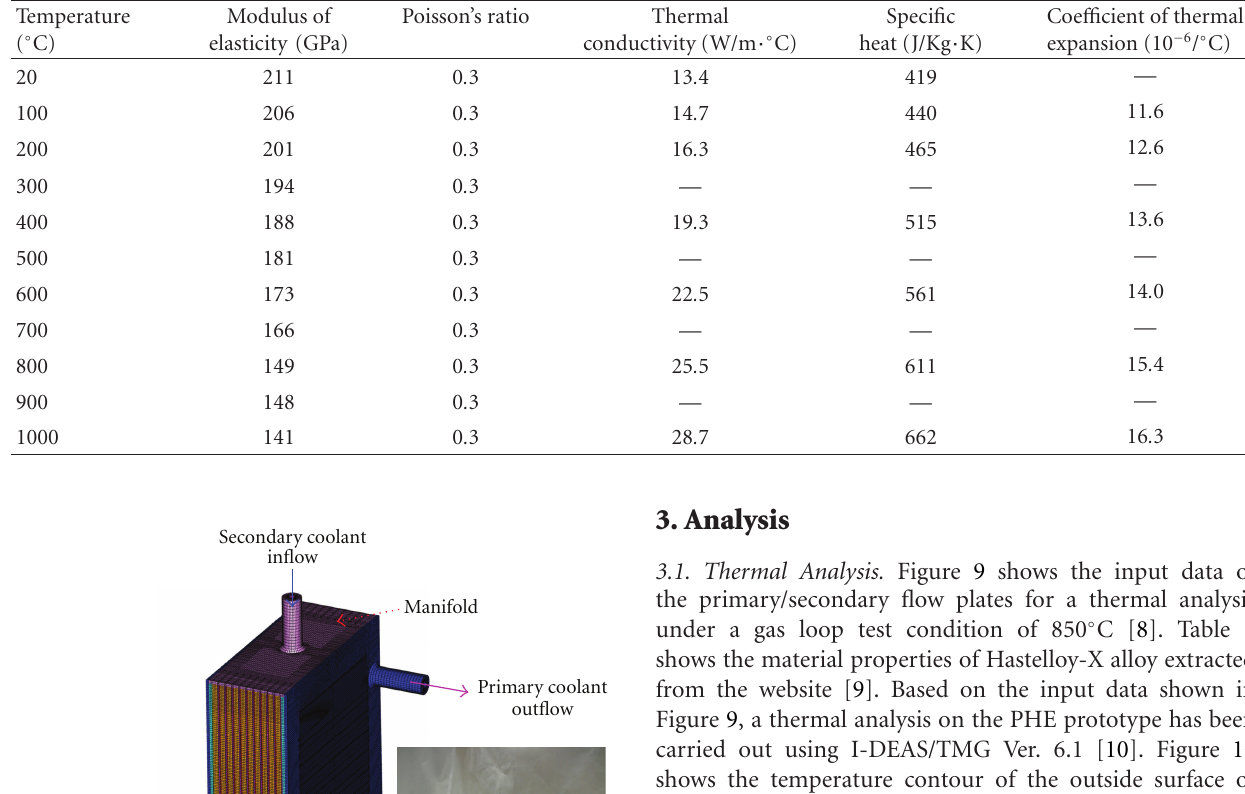
Table 1: Material properties of Hastelloy-X alloy.